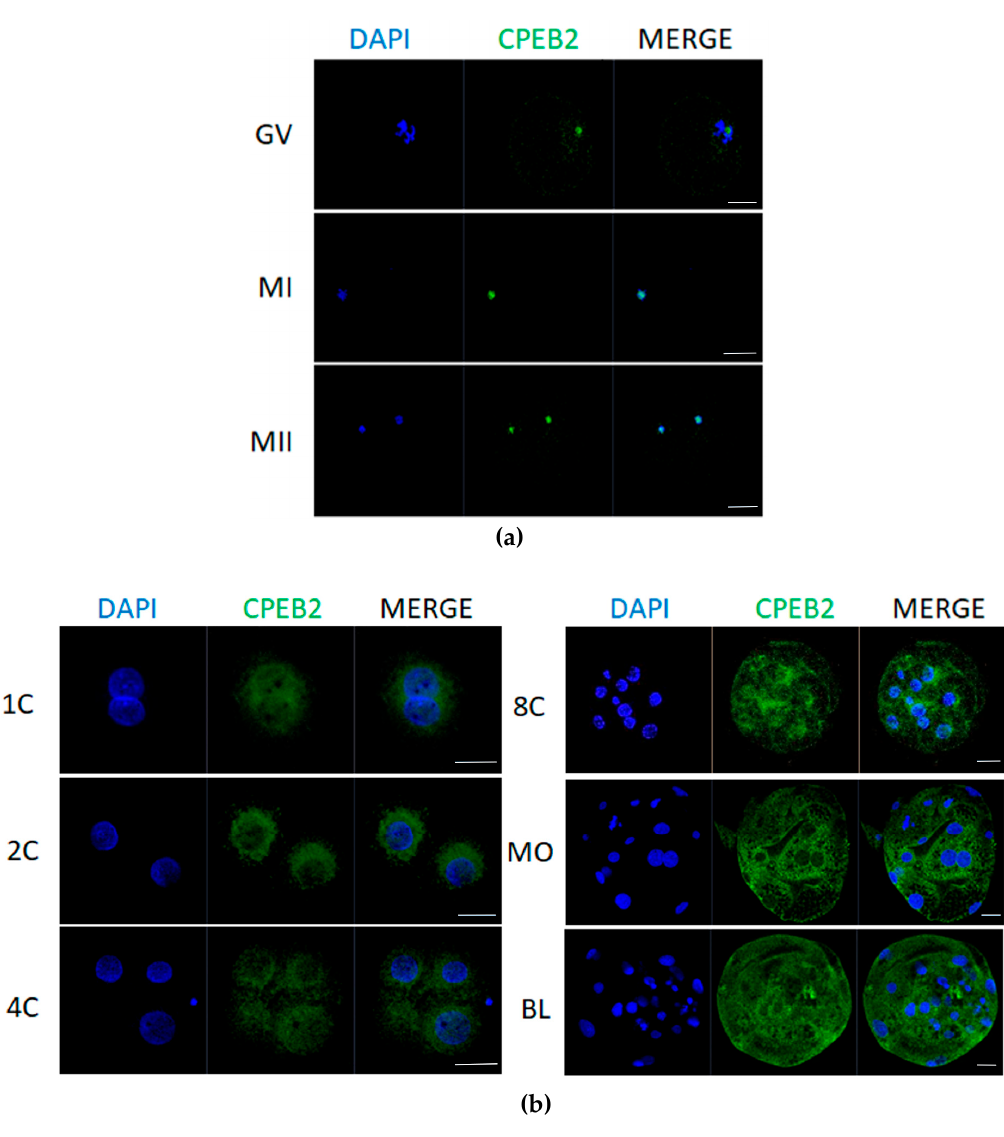
Figure 5. Localization of CPEB2 protein in porcine oocytes and embryos. ( a ) Representative confocal images of porcine GV, MI, and MII oocytes. Scale bars = 50 μ m. ( b ) Representative confocal images of porcine pronuclear (1C), two-cell (2C), four-cell (4C), eight-cell (8C), morula (MO), and blastocyst (BL) parthenogenetic embryos. Scale bars = 100 μ m. A minimum of 50 oocytes and embryos derived from four independent replicates were analyzed. Micrographs show the ICC detection of CPEB2 (green) and DNA (DAPI, blue).